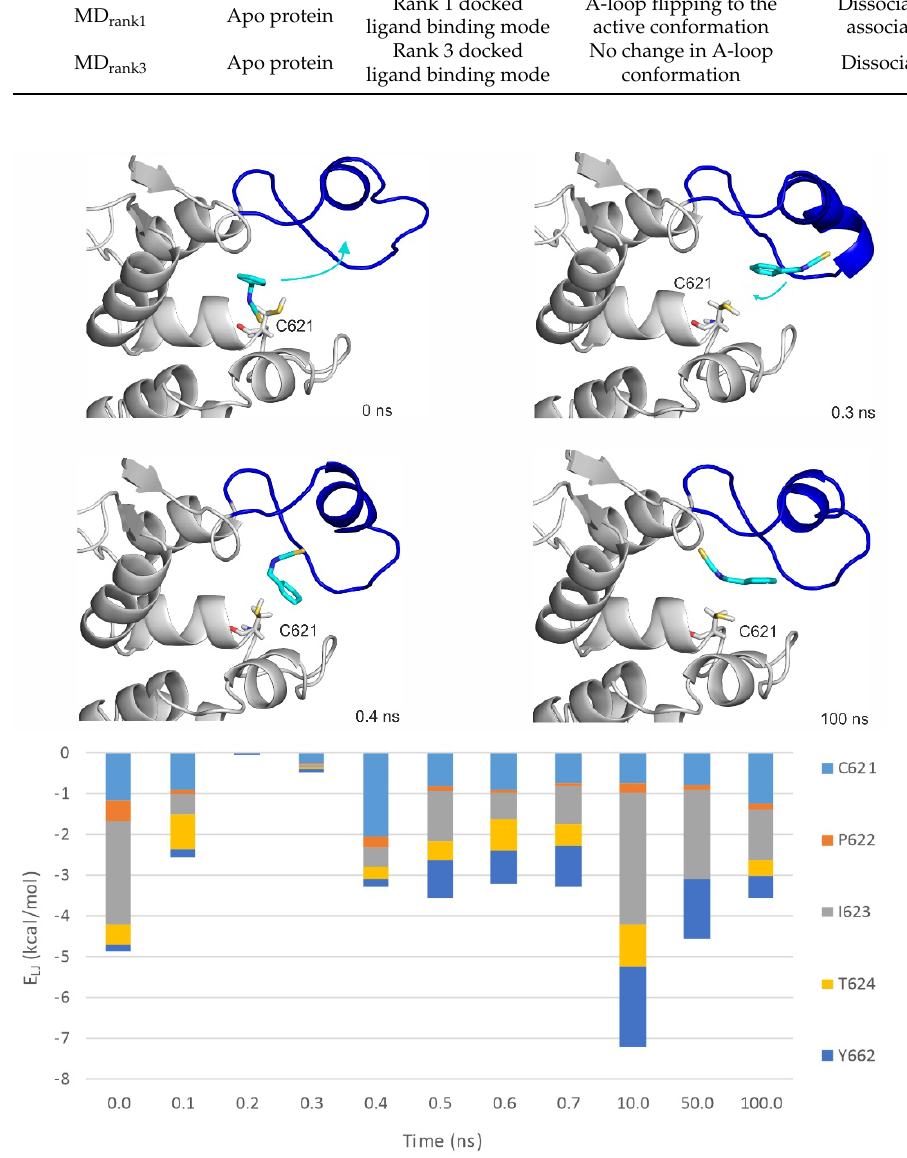
Figure 4. The MD holo simulation starting from the experimental binding position, with the covalent bond cut. Interaction energy distribution of the interacting amino acids of the pocket (inner prerequisite site) is shown during the MD simulation. The structural figures are snapshots of the binding position of BITC at the stated time frame of the MD simulation. The protein is shown in grey cartoon and BITC with teal sticks. The A-loop is marked with blue in the open conformation. C621 amino acid is also shown as all atom sticks representation. The teal arrows indicate the movement of BITC. Lennard–Jones interaction energies calculated between BITC and the TRPA1 target amino acids are shown per residue on the diagram.